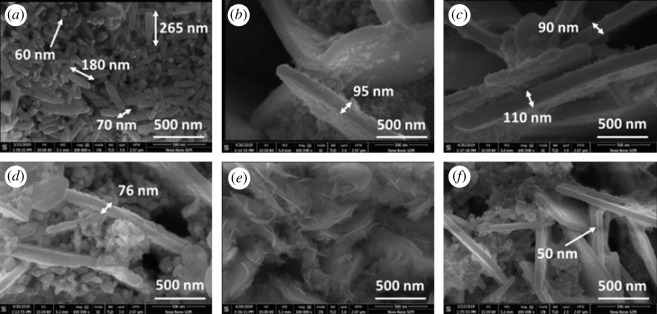
FESEM images of the (a) pure BFO NRs, (b) x = 0.00, (c) x = 0.03, (d) x = 0.05, (e) x = 0.07 and (f) x = 0.1 in BiFe0.9Co0.1−xNixO3 nanoplates.